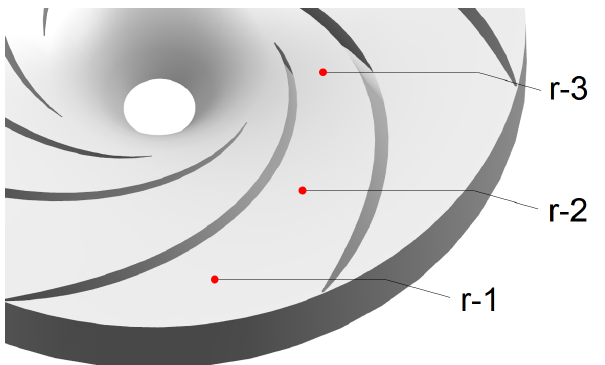
Figure 19. Relative position of pressure monitoring points in